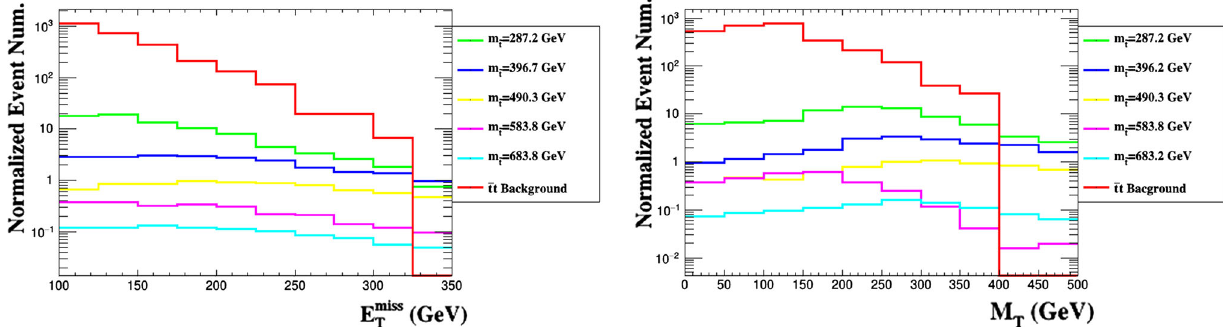
Fig. 6 Plots representing the E miss